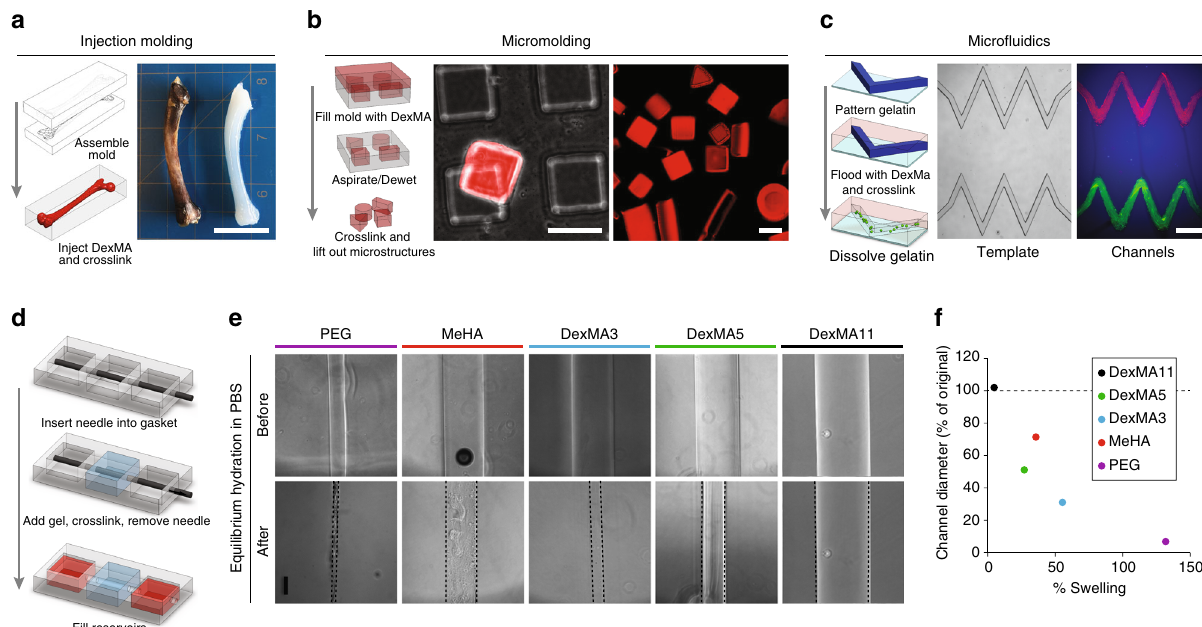
Fig. 2 Multi-scale molding and micro fl uidic integration of non-swelling DexMA. a Replica-molding of DexMA to duplicate the gross anatomical features of a bone. A negative mold of the bone was generated in PDMS, fi lled with DexMA gel precursor solution, and UV crosslinked to yield the bone replicate ( scale bar , 1 cm). b DexMA micro-gels were similarly fabricated by replica-molding using PDMS molds generated by traditional SU8 photolithography ( scale bars , 100 μ m). c Patent micron-scale fl uidic channels embedded within non-swelling DexMA gels. Sacri fi cial channel structures were micromolded in gelatin as in ref. 32 , DexMA gels were cast on top, and gelatin was dissolved at 37 °C to yield open channels. Bright fi eld and fl uorescence image demonstrating channel perfusion by red and green fl uorescent beads ( scale bar , 500 μ m). d Schematic depicting fabrication of tubular channels embedded within 3D hydrogels. e Images of channels immediately after needle removal, and following equilibrium hydration. Swelling hydrogels (DexMA3, DexMA5, MeHA, PEG) all result in channel closure in contrast to non-swelling DexMA11. Scale bar , 100 µ m. f Degree of channel closure (% of initial channel width) as a function of hydrogel swelling (de fi ned as % of initial gel